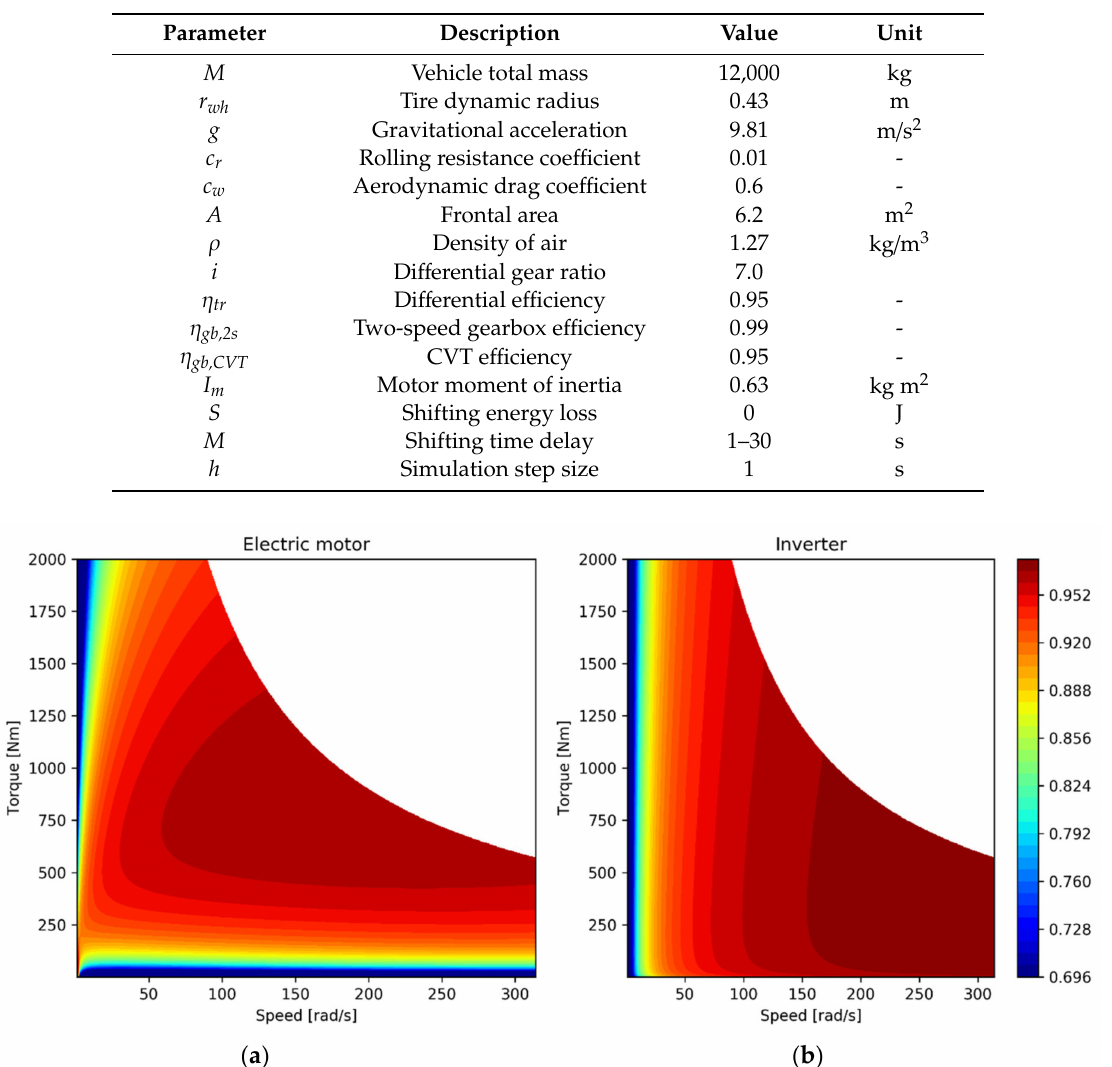
Table 1. Parameter values for the numerical case study.